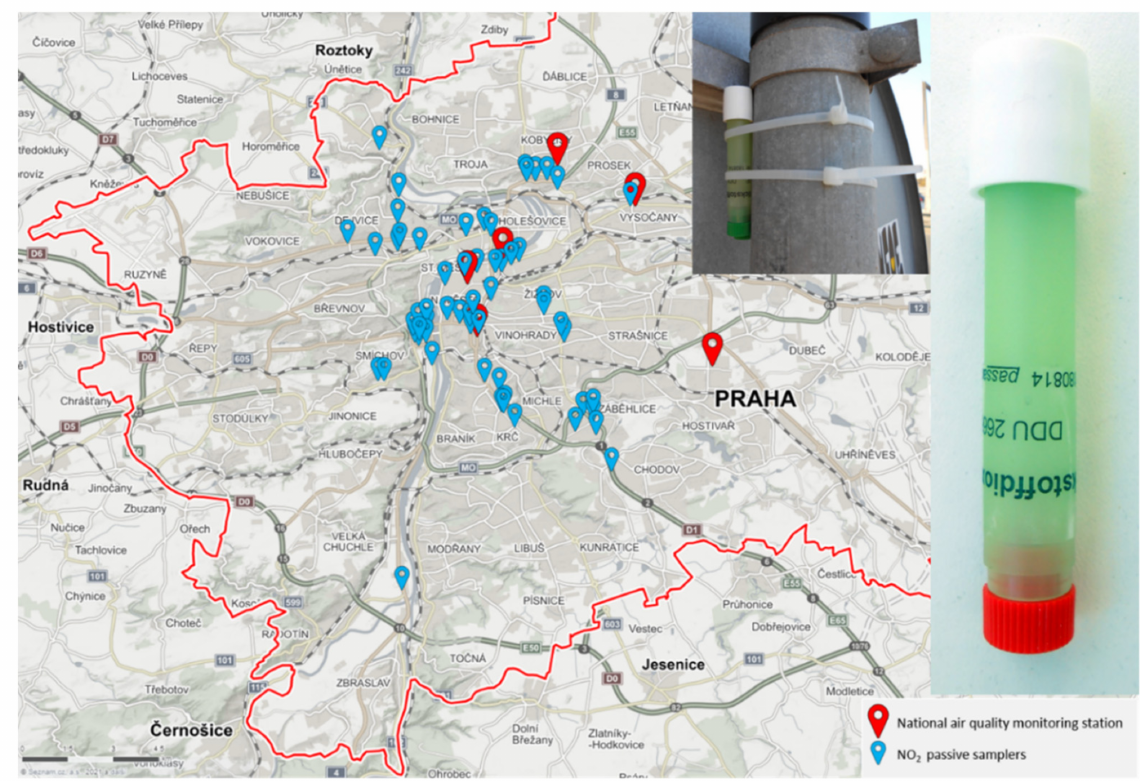
Figure 1. Locations of the passive samplers and air quality monitoring stations used for comparison in this study. Photo of a sampler is shown in the upper right corner. (Map source: www.mapy.cz (accessed on 18 May 2021), © Seznam.cz, a.s., used with